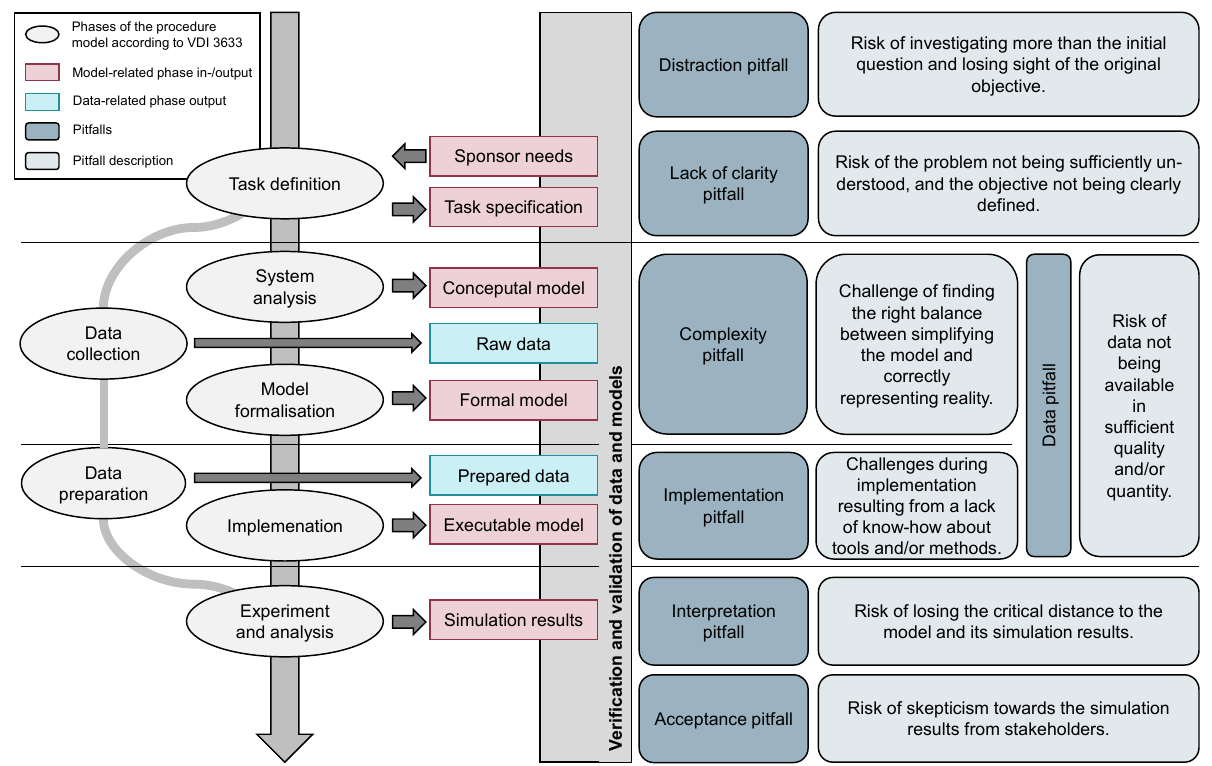
Figure 9. Assignment of pitfalls to the time of their occurrence in the procedure model for simulation studies according to VDI guideline 3633 [9].